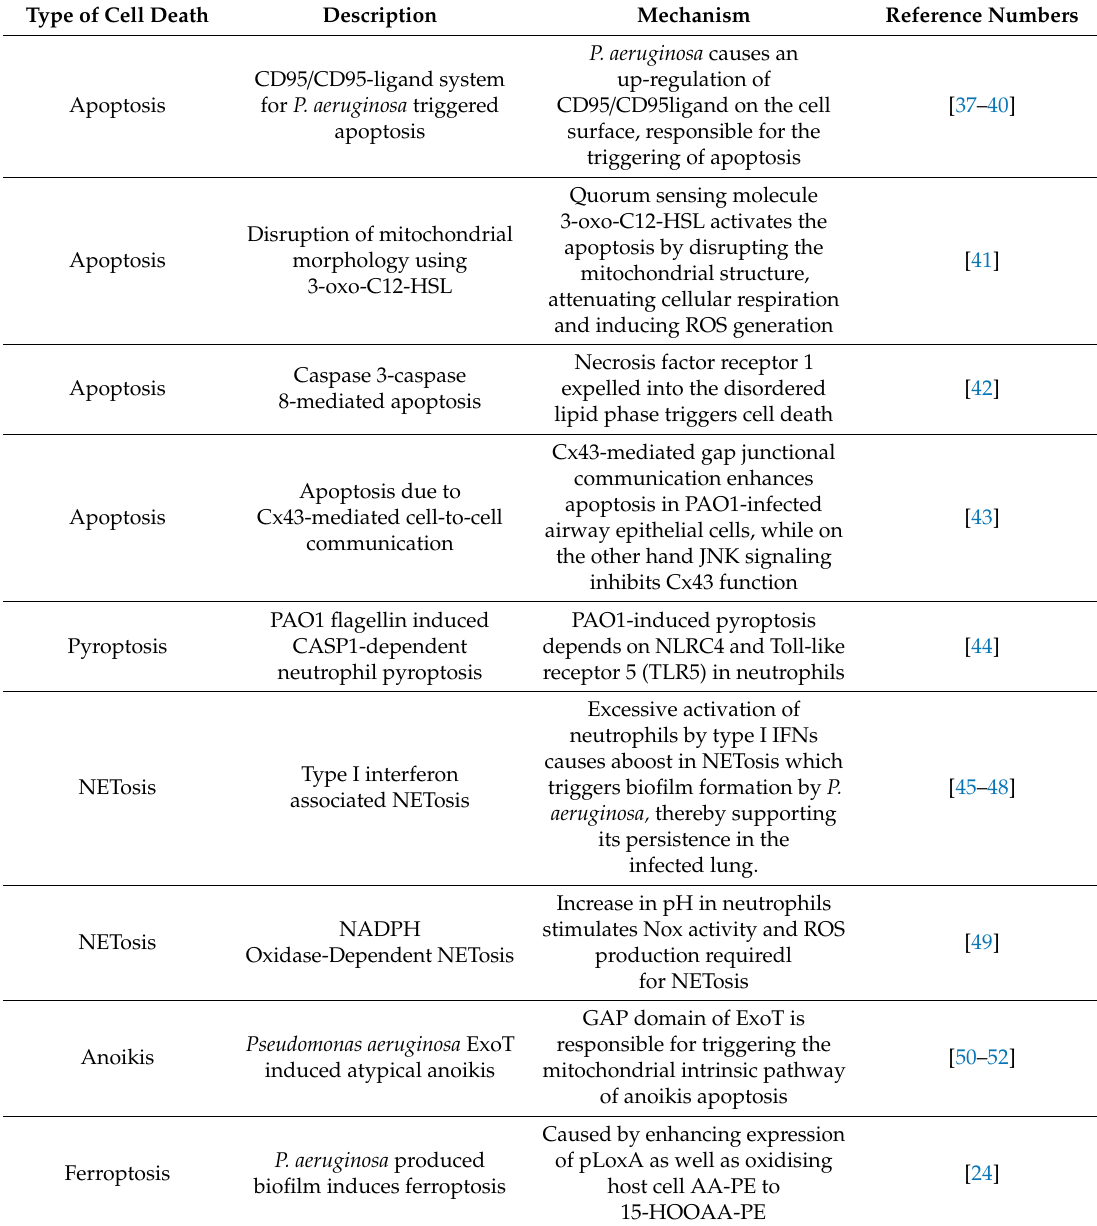
Table 1. A summary of di ff erent mechanisms underlying the di ff erent types of epithelial cell